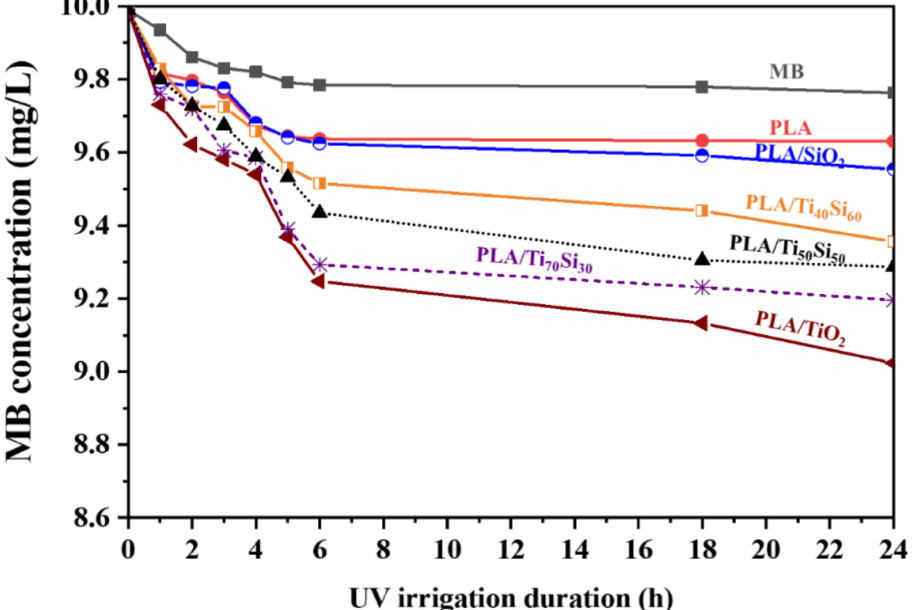
Figure 22. Concentration of methylene blue (MB) due to absorption of PLA film and PLA/Ti x Si y oxide (synthesized at pH 9.0 with different Ti/Si ratios) films under UV